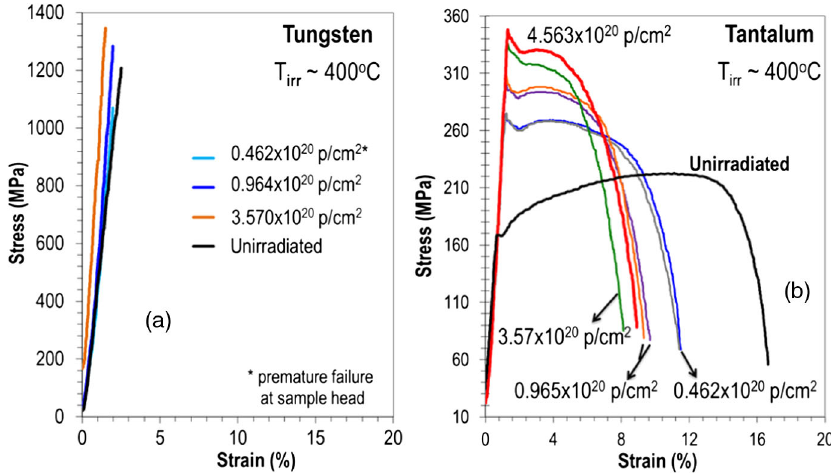
FIG. 27. Proton irradiation effects on stress-strain behavior of (a) tungsten and (b)